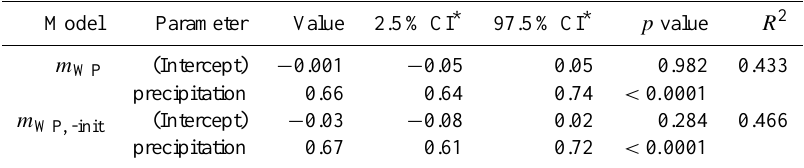
Table 3. Coefficient of the linear model of wood productivity with the precipitation; with all data m WP or after removing the first month of the dry season and wet season (defined, respectively, as the first month with precipitation > 100mm and the first month with precipitation < 100mm), m WP, -init